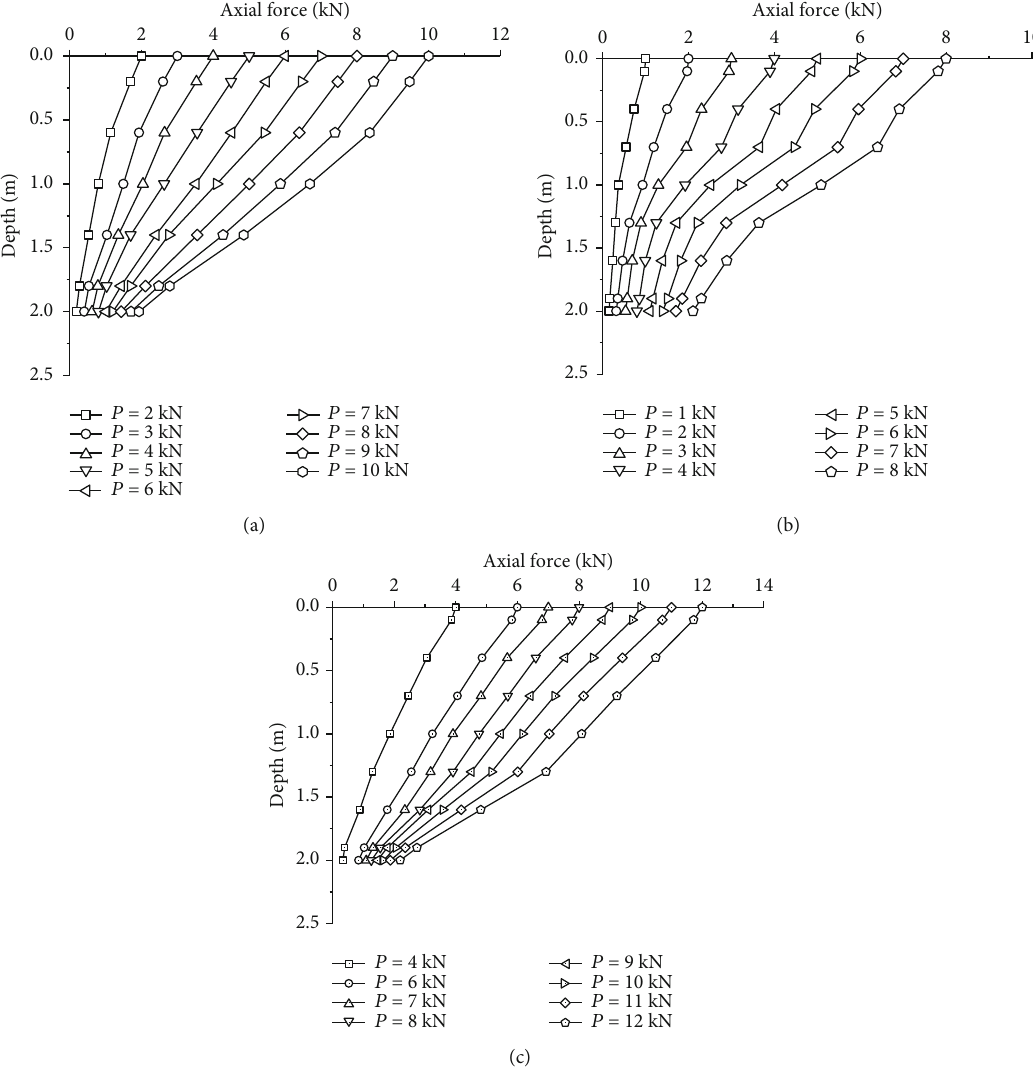
Figure 7: Axial force distributions along pile depth: (a) Y pile; (b) C